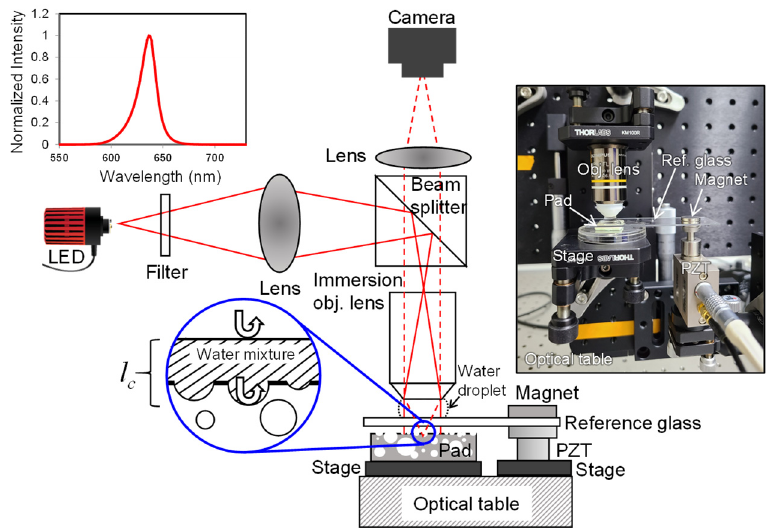
Figure 1. A schematic of the implemented system for CMP pad surface measurement. PZT, piezo electric actuator. l c , coherence length. Insets (left top and right) are a spectrum of the light source and a picture of the common-path of the system, respectively.